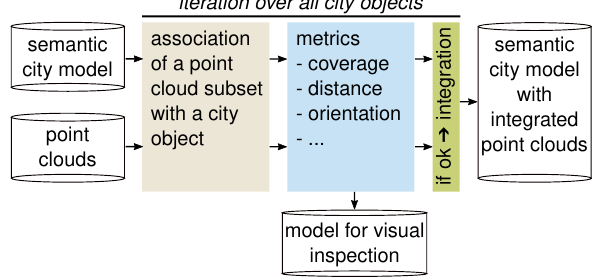
Figure 4. Method overview for integrating point clouds with semantic models utilizing quality metrics.